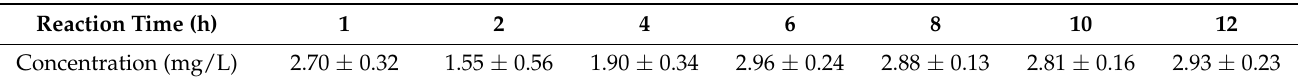
Table 8. The Pb leaching concentration of precipitate obtained at different times (mg/L).